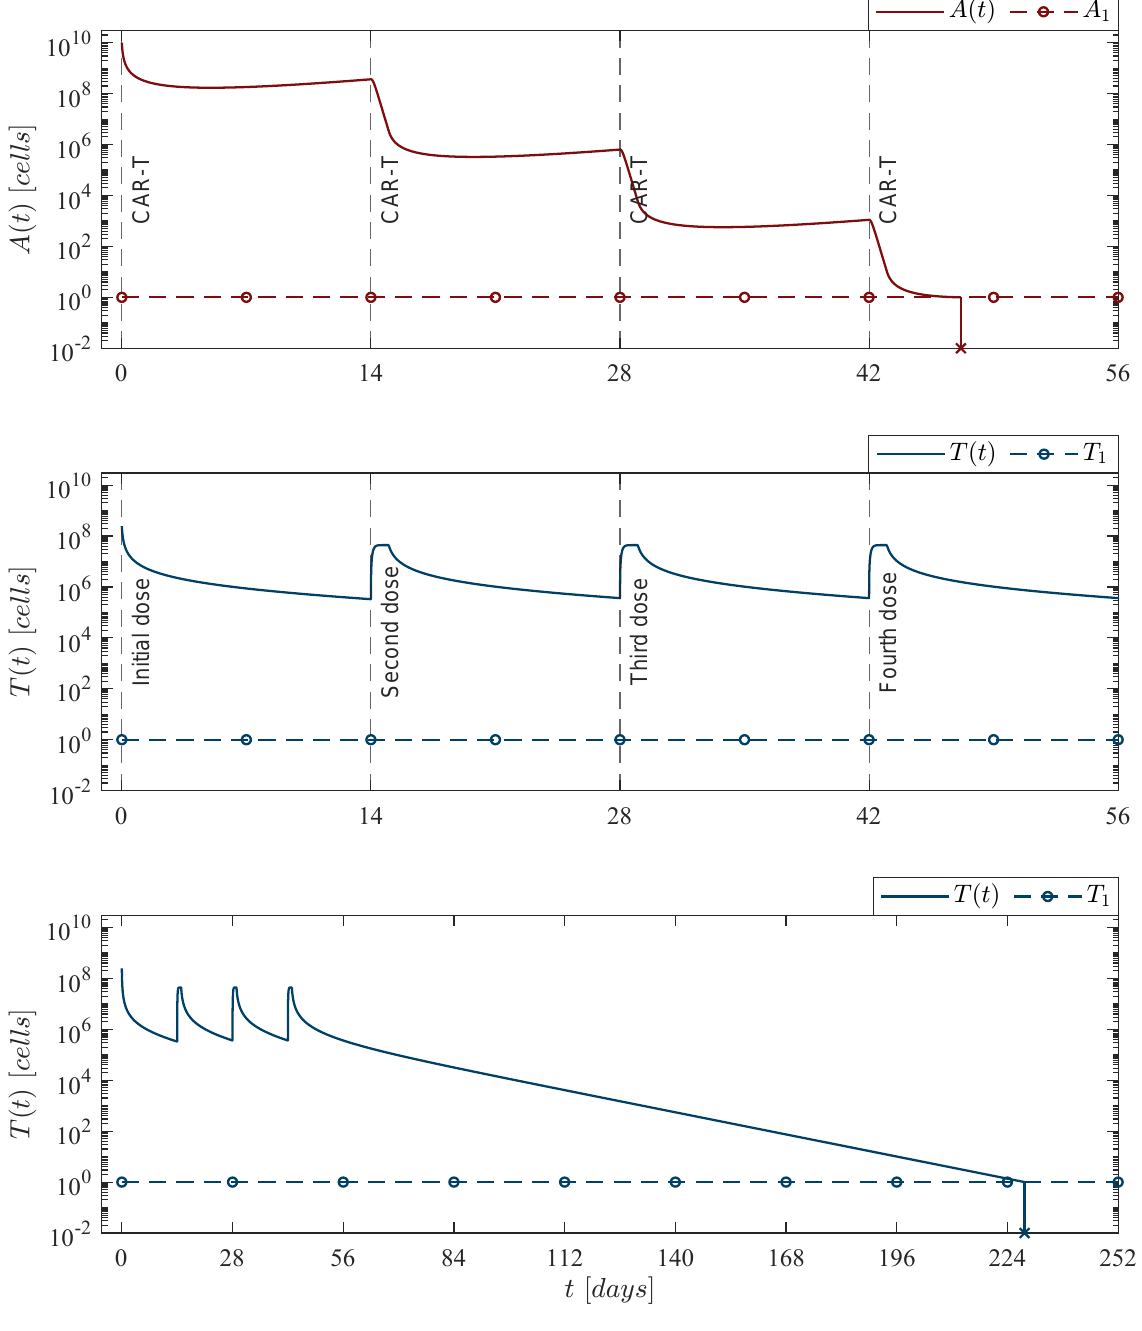
Figure 6. Fortnight CAR-T cells case. Four doses of 245,633,284 CAR-T cells were applied at days 0, 14, 28, and 42, for a total of 982,533, 136 CAR-T cells infused into the system to achieve leukemia cancer cells eradication [ A ( t ) < 1 ] between days 47 and 48 [ t = 47.16 ] . The lower panel illustrates that CAR-T cells are completely depleted [ T ( t ) < 1 ] by day 229 [ t = 228.34 ] . For this case, parameter values are set as follows: ρ A = 0.1680, ρ T = 2.9409 × 10 − 13 , µ T = 1/14, and α T = 1.2560 × 10 − 7 by Equation